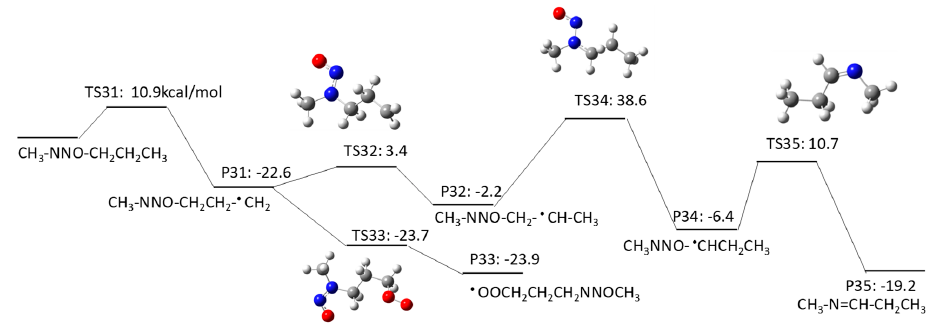
Figure 9. Free energy profile for pathway 3–3 of the HO • -induced reaction pathways for NMBA via H abstraction from a C–H bond of the terminal CH 3 functional group in a butyl chain. The numbers (kcal/mol) are the free energy of activation for the TS and free energy of reaction for the P relative to the corresponding reactant.